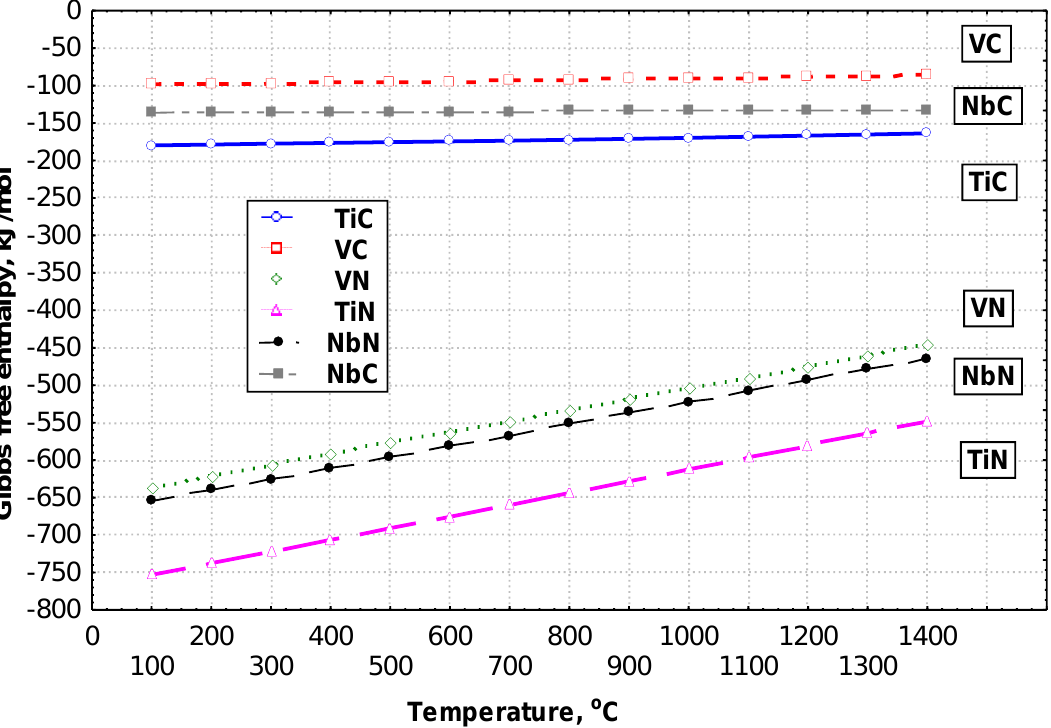
Figure 1. Free enthalpy of the formation of carbides and nitrides, calculated per one atom of carbon or nitride [32].